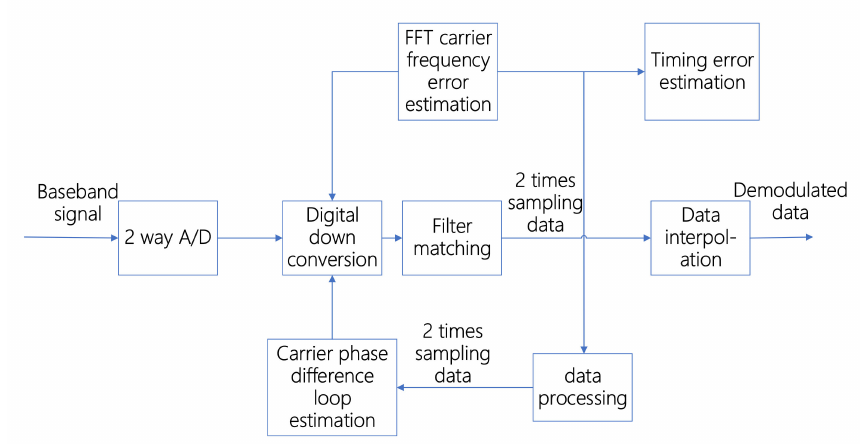
Figure 7. Schematic diagram.